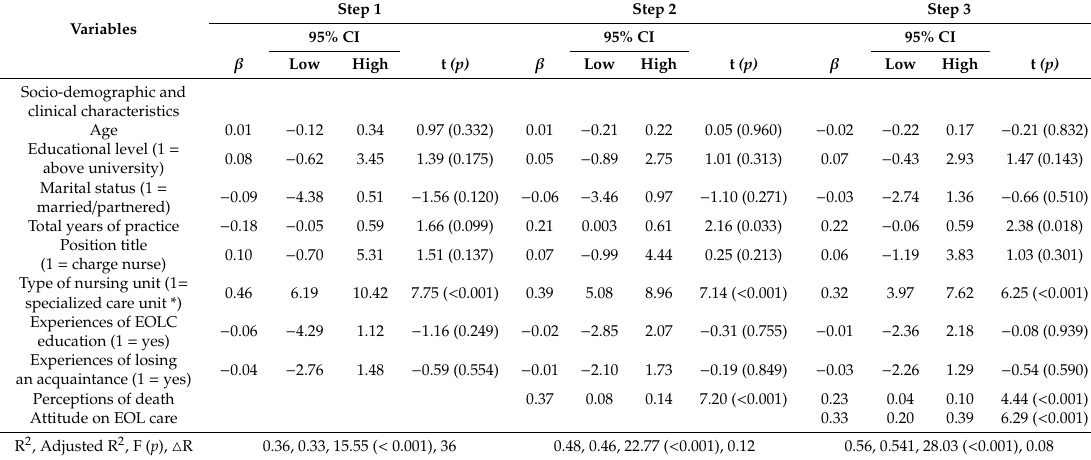
Table 4. Hierarchical Linear Regression Analysis Predicting Self-reported Performance on EOL Care among Hospital Nurses. ( N = 230).